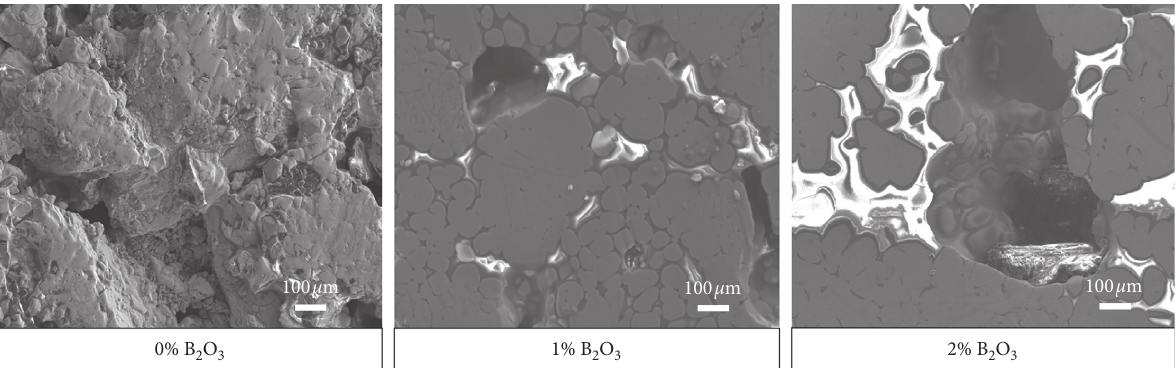
Figure 9: SEM images of pellets with different B